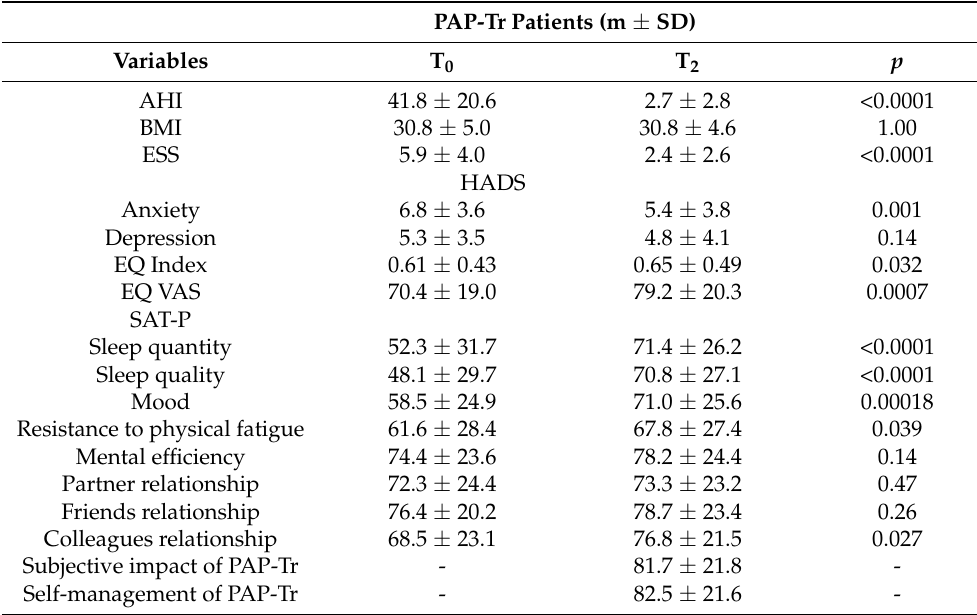
Table 2. Comparison of clinical, psychological, and HRQoL data of OSA patients at baseline and 1 year of PAP treatment (n = 59).